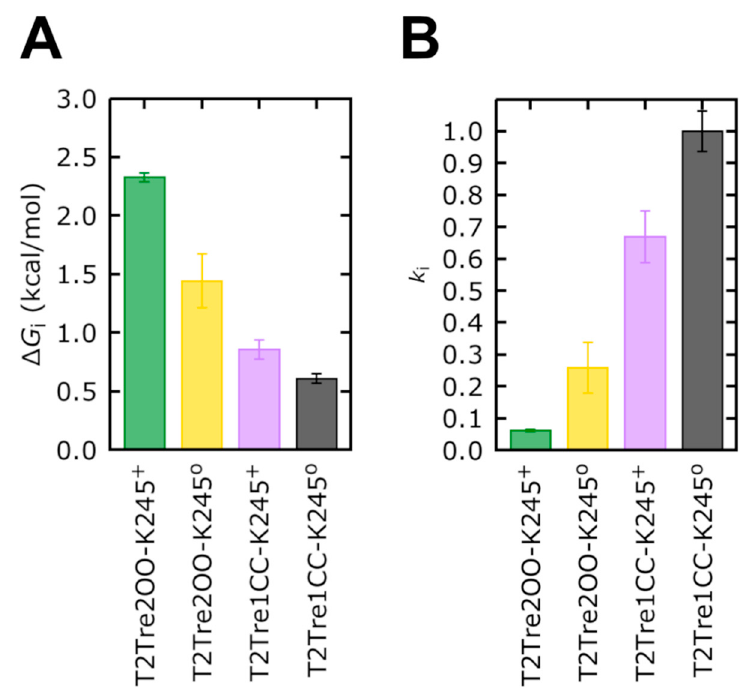
Figure 8. Free energy and rate constants of K245 in TASK-2 channel. ( A ) The free energy ∆ G i cost and ( B ) the kinetic rate constant k i were obtained from the highest barrier in the PMF simulations. k i was calculated from the Equation (1).